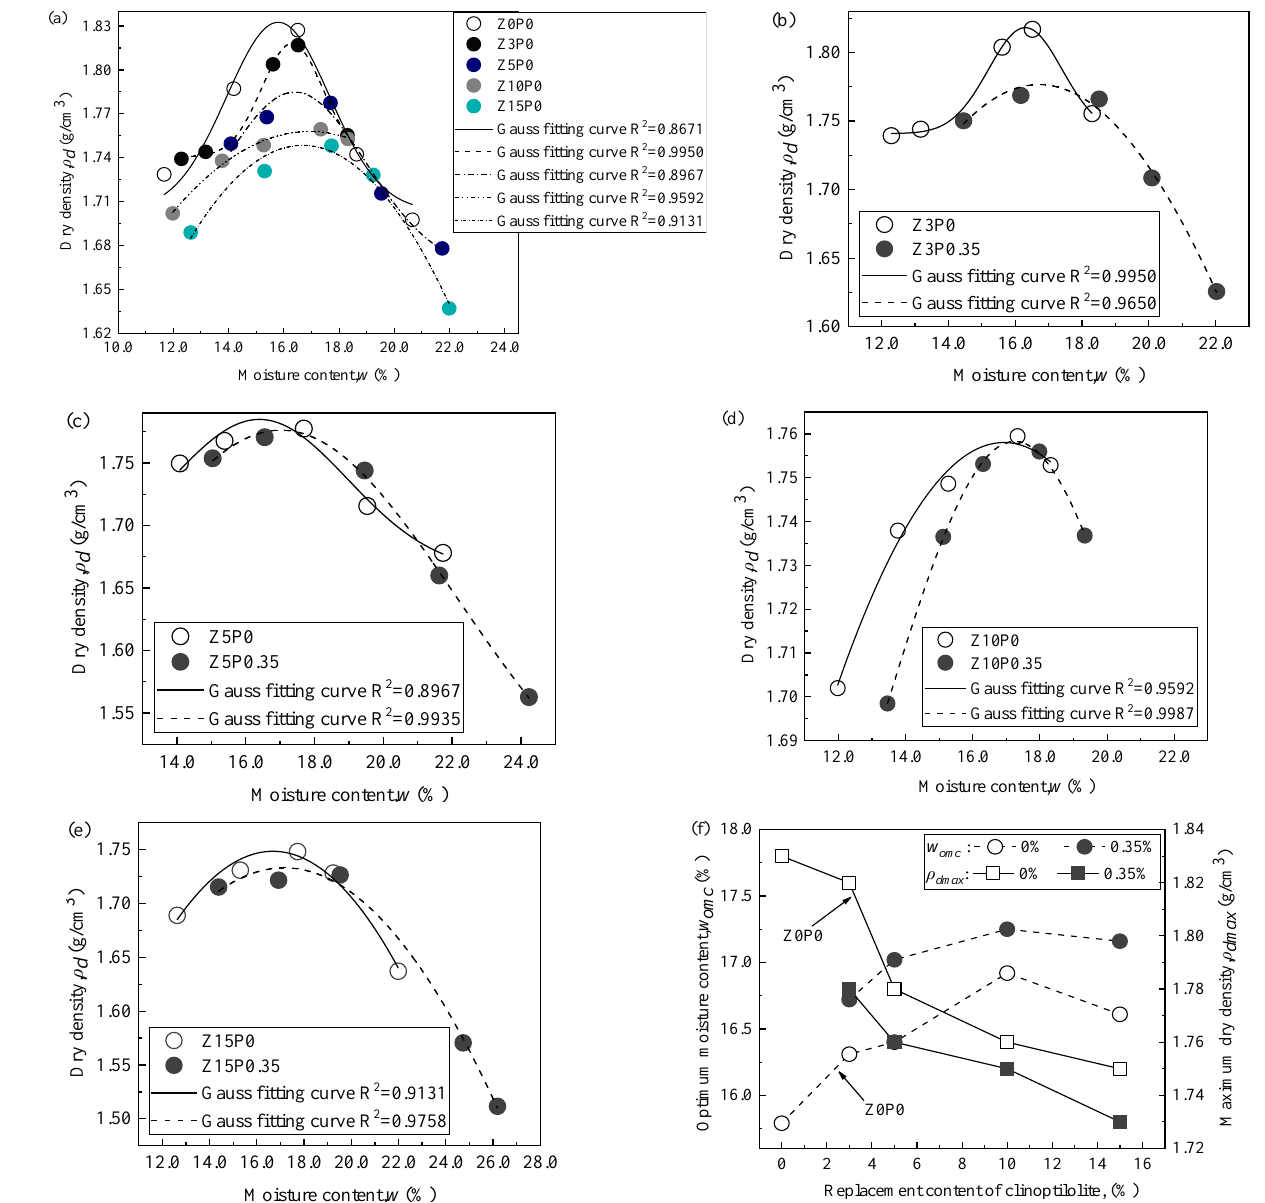
Figure 8. Compaction curve of CCC modified by different water-retaining agent materials. ( a ) Different replacement contents of clinoptilolite; ( b ) Z3P0.35, ( c ) Z5P0.35, ( d ) Z10P0.35, and ( e ) Z15P0.35; ( f ) optimum moisture content and maximum dry density changes.